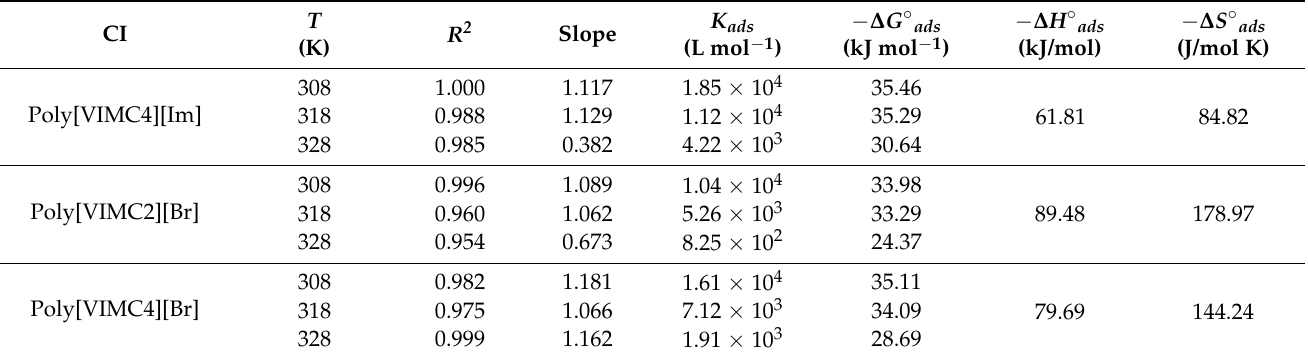
Figure 11. Adsorption isotherms of API 5L X60 steel in 1 M H 2 SO 4 in the presence of PILs at different temperatures: ( a ) 308 K, ( b ) 318 K and ( c ) 328 K. Table 5. Thermodynamic parameters of API 5L X60 steel in the presence of 1 M H 2 SO 4 —CIs at different temperatures.